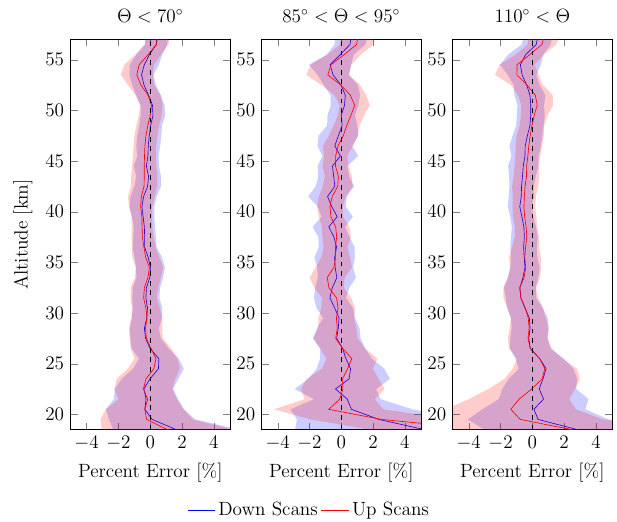
Figure 9. Mean percent error between the ozone profile retrieved when using five diffuse profiles in the forward model and the simu- lated known value, i.e. ( [ O 3 ] ( 5 ) − correct )/ correct · 100%.